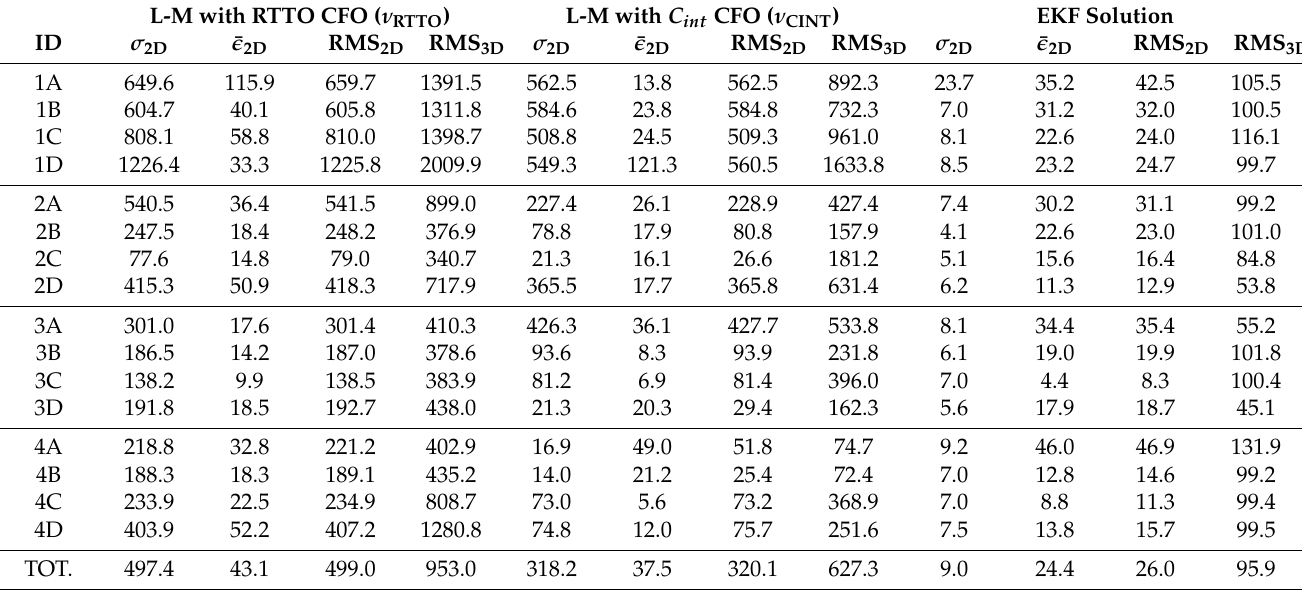
Table 1. Non-weighted statistics of 3D position estimates (all values in centimeters).